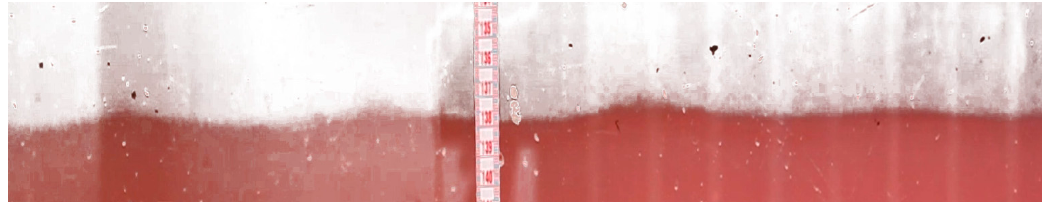
Figure 12. Photograph of K-H waves at the interface in the test.